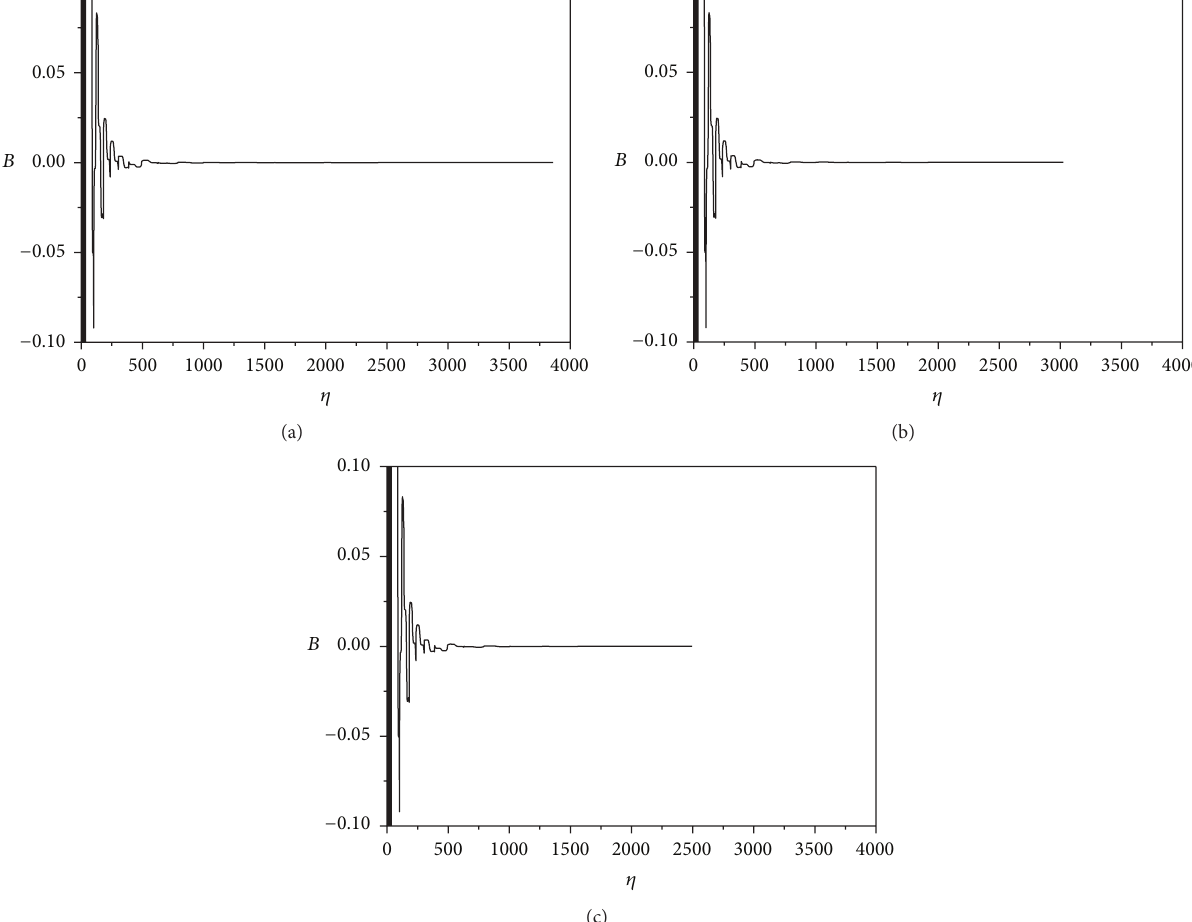
decay for different values of the mass of the field 𝑚 and for different fixed values of the other parameters of the